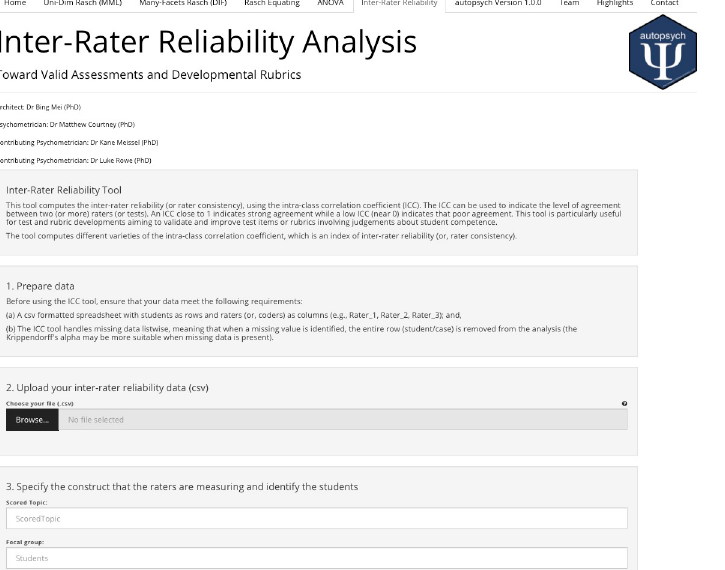
Fig 17. Inter-rater reliability